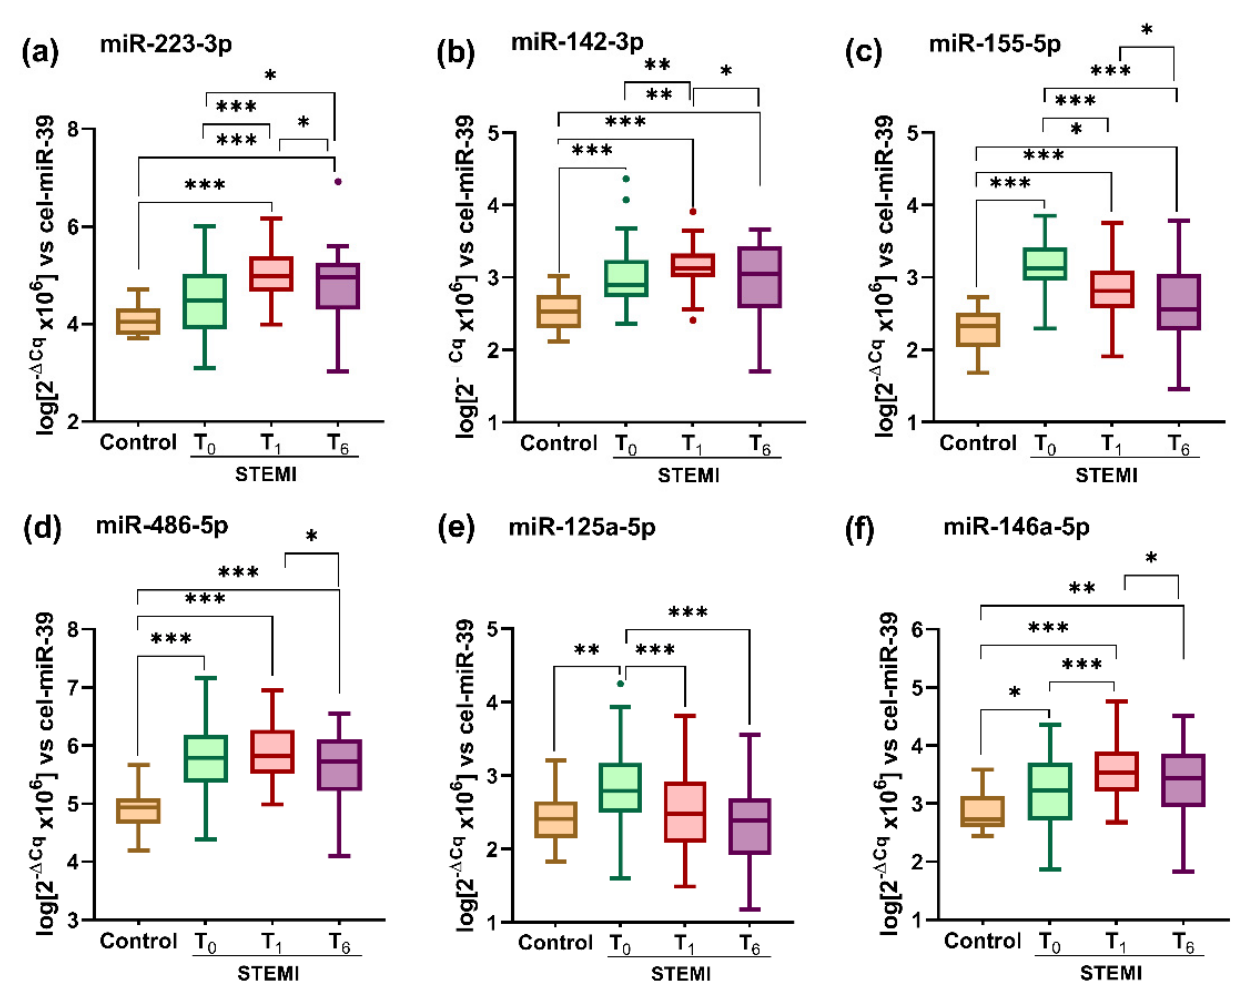
Figure 1. Levels of miRNAs ( a – f ) in the plasma of ST-segment elevation myocardial infarction (STEMI) patients at T 0 , T 1 , and T 6 time points and of controls. Data are illustrated as boxplots with Tukey whiskers and median line. * p < 0.05; ** p < 0.01; *** p < 0.001.